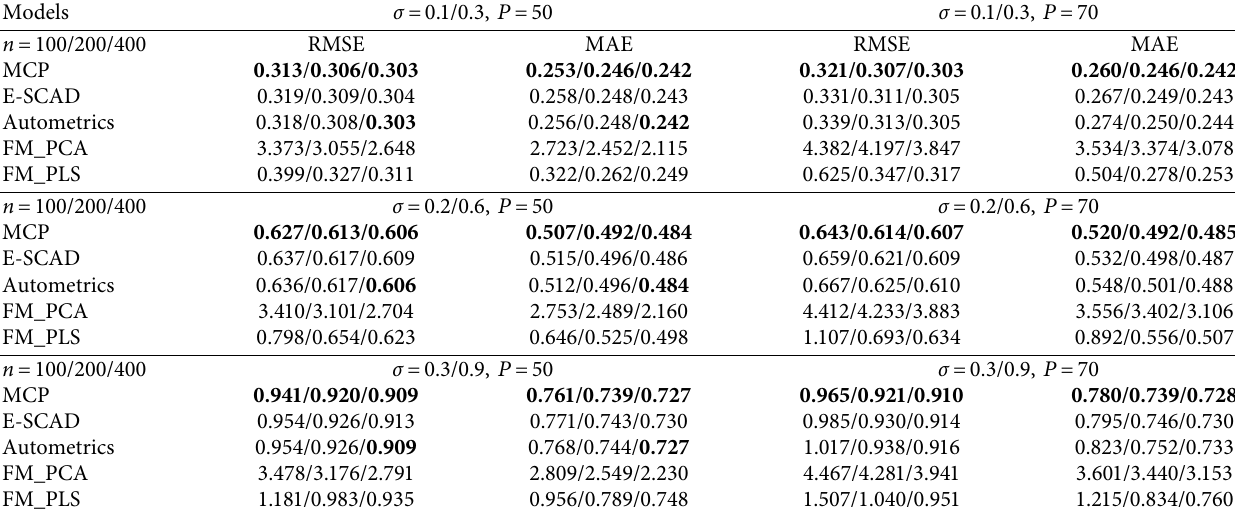
Table 2: Forecast comparison under heteroscedasticity from Monte Carlo simulation (Scenario 2).